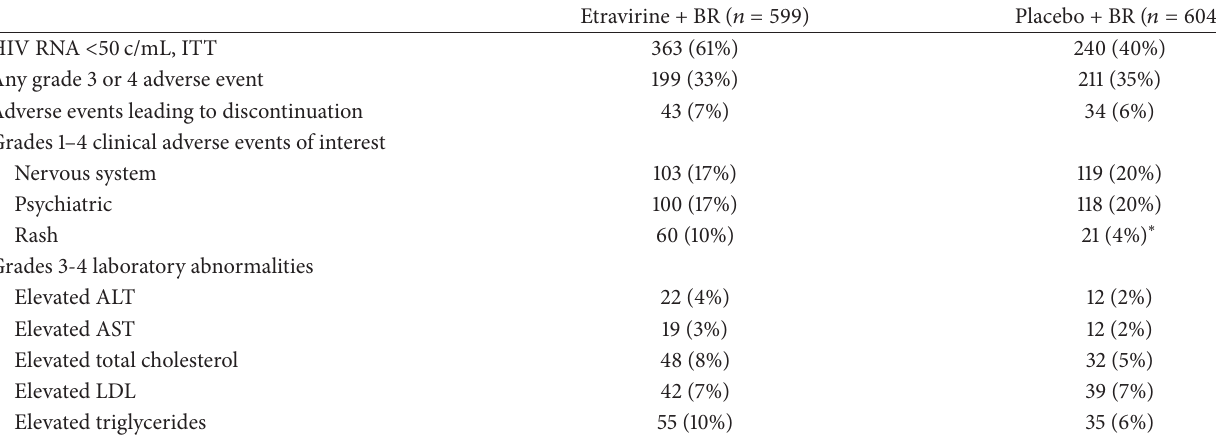
Table 2: DUET trials: summary efficacy and safety results by treatment arm, to Week 48.